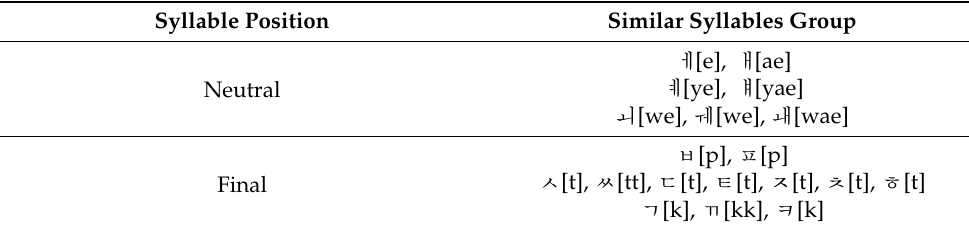
Table 5. Similar Syllables Group Table.